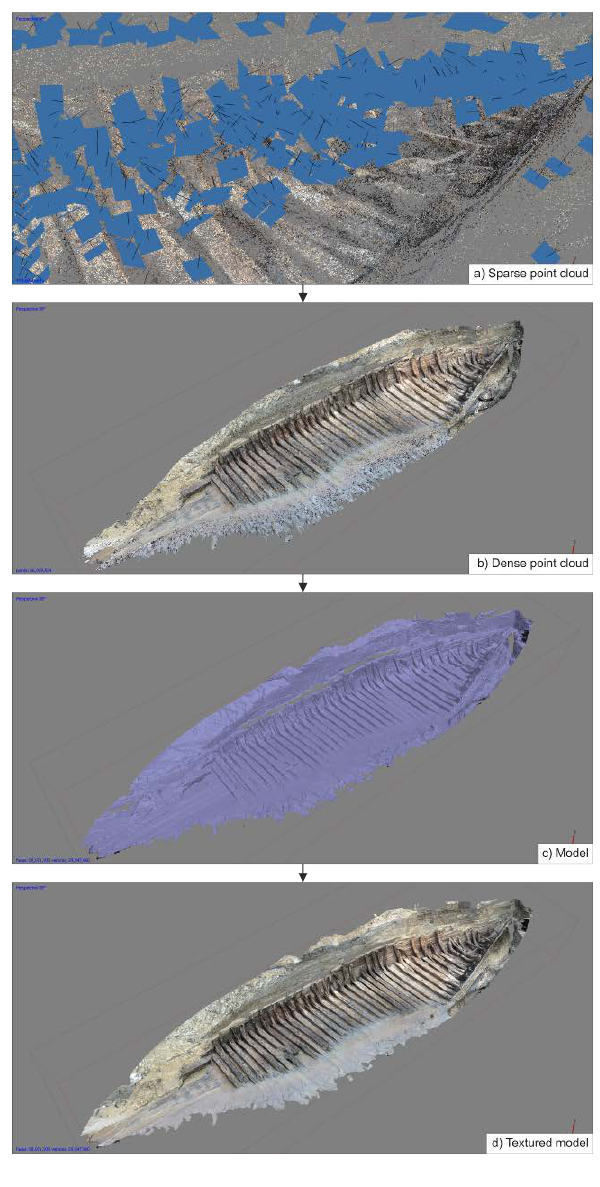
Figure 3. Data processing